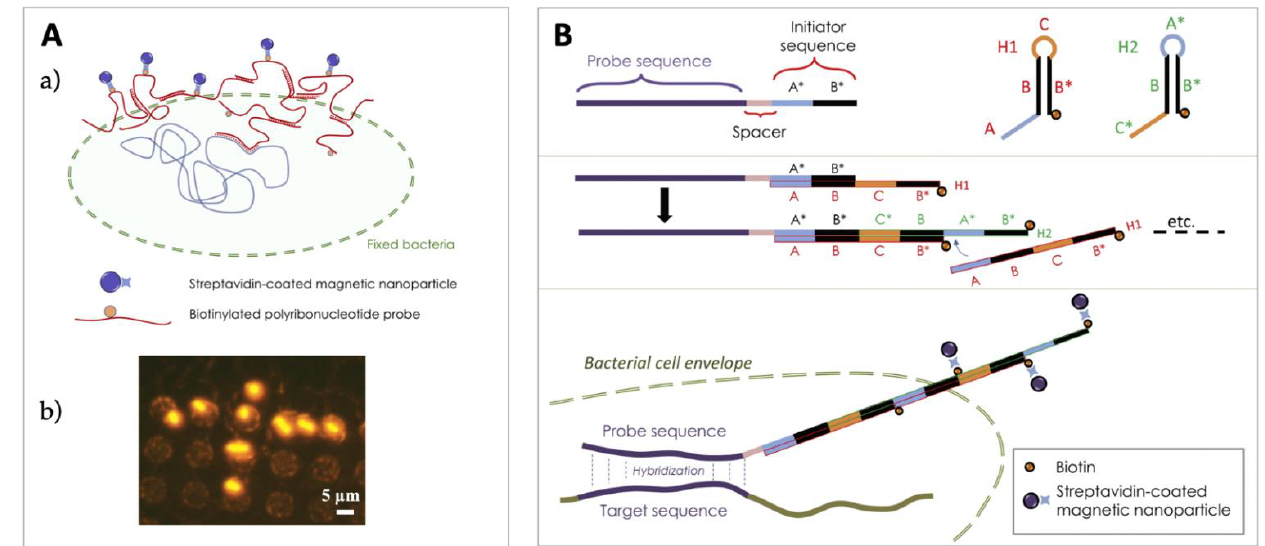
Figure 8. Magnetic fishing. ( A ) ( a ) Schematic illustration of magnetic in situ hybridization. ( b ) E. coli bacteria targeted by this approach and trapped on an array of 7.5 × 7.5 µm 2 magnets. Reprinted with permission from [65]. Copyright © 2014 Elsevier B.V. B. Principle of HCR-MISH. ( A ) ( a ) and ( B ) reprinted with permission from [66]. Copyright © 2018 Elsevier B.V.